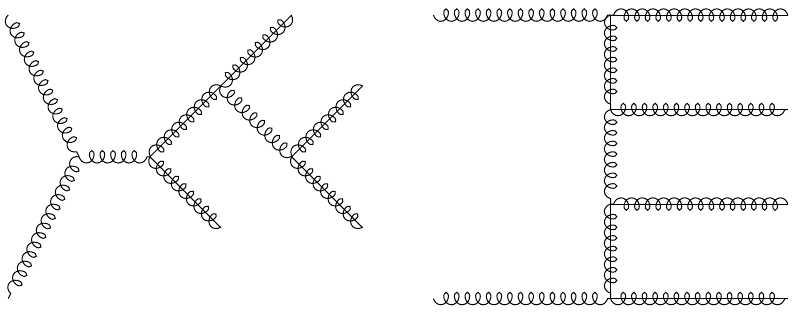
Figure 2: Example Feynman diagrams that contribute to the g g → ˜ g ˜ g ˜ g ˜ g matrix